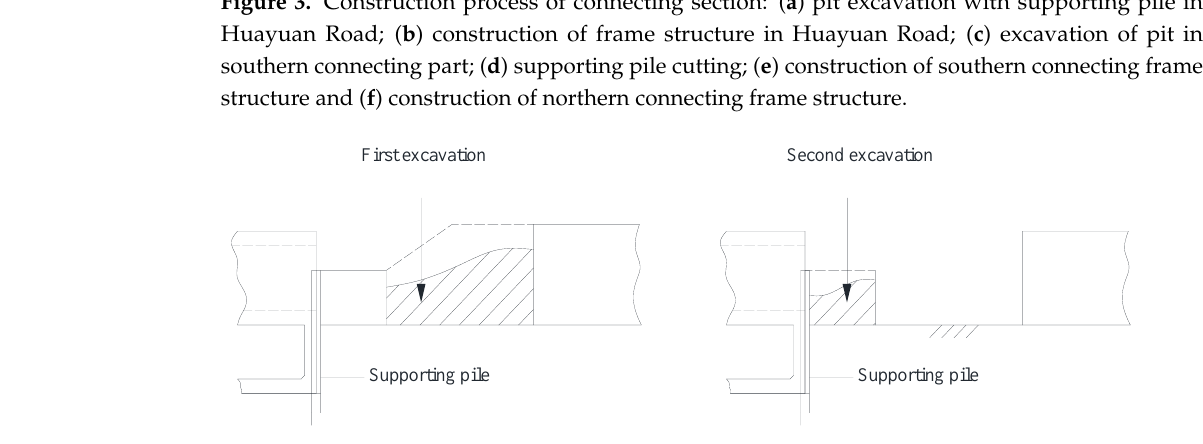
Figure 4. Excavation of foundation pit behind supporting pile.